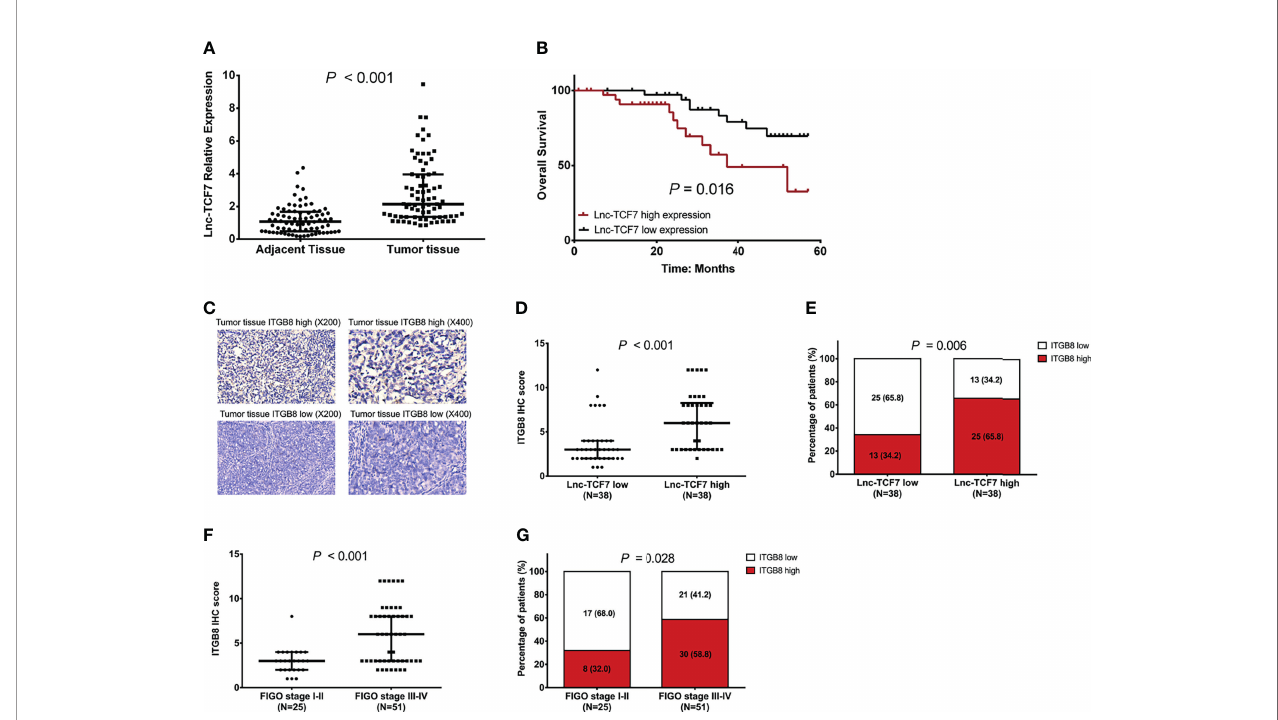
FIGURE 9 | Correlation of lnc-TCF7 with ITGB8 and survival. The expression of lnc-TCF7 in tumor tissue and adjacent tissue of EOC (A) ; The correlation of lnc- TCF7 with OS in EOC patients (B) ; The correlation of lnc-TCF7 with ITGB8 expression in EOC tumor tissue (C – E) ; The correlation of ITGB8 with FIGO stage (F, G)